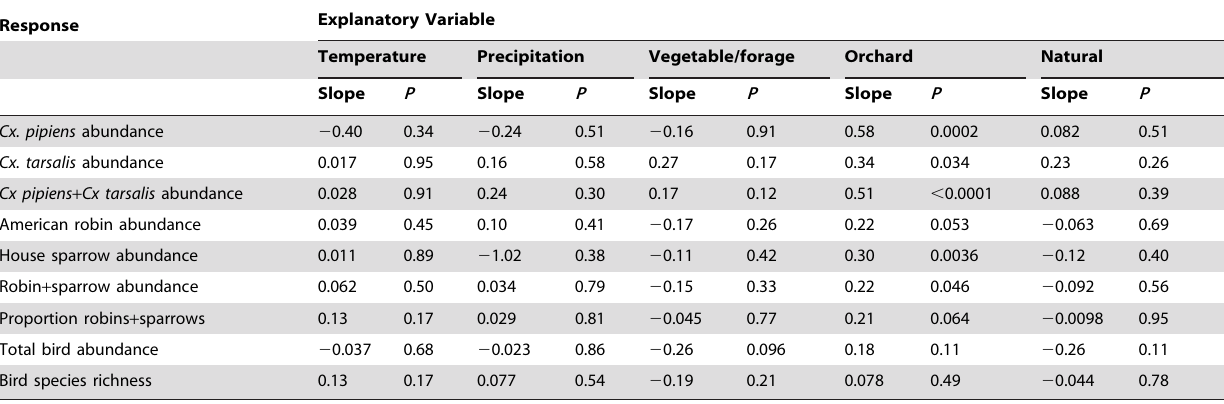
Results from a multiple regression model on effects of land-use and climate on mosquito and bird abundance and community composition.